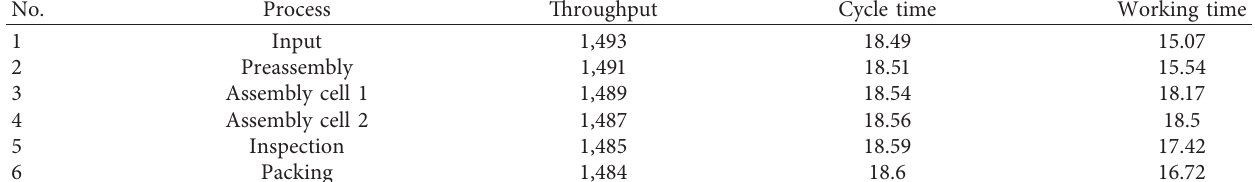
Table 4: Throughput, cycle time, and working time per process in the line according to work time reorganization.